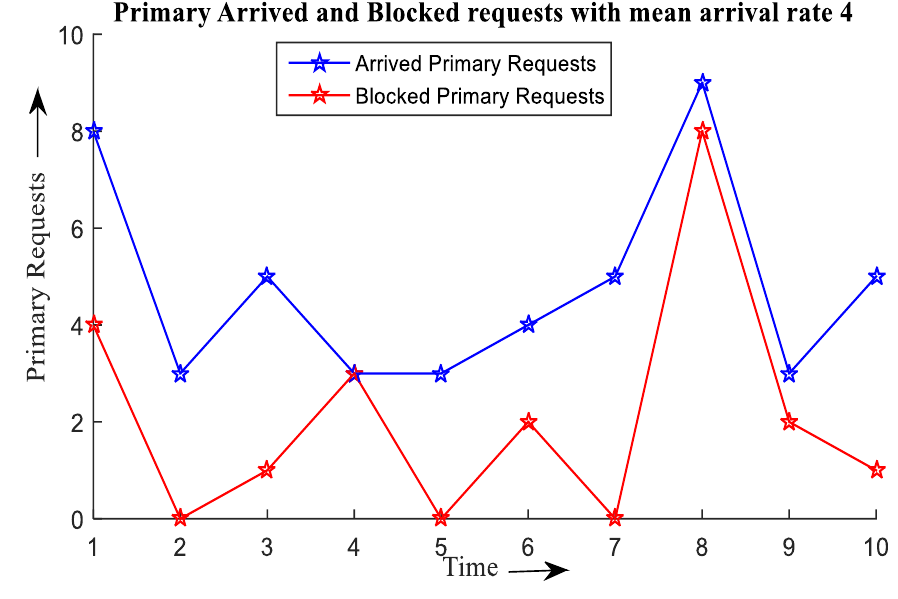
Figure 4. Primary arrived and blocked requests ( λ = 4 )